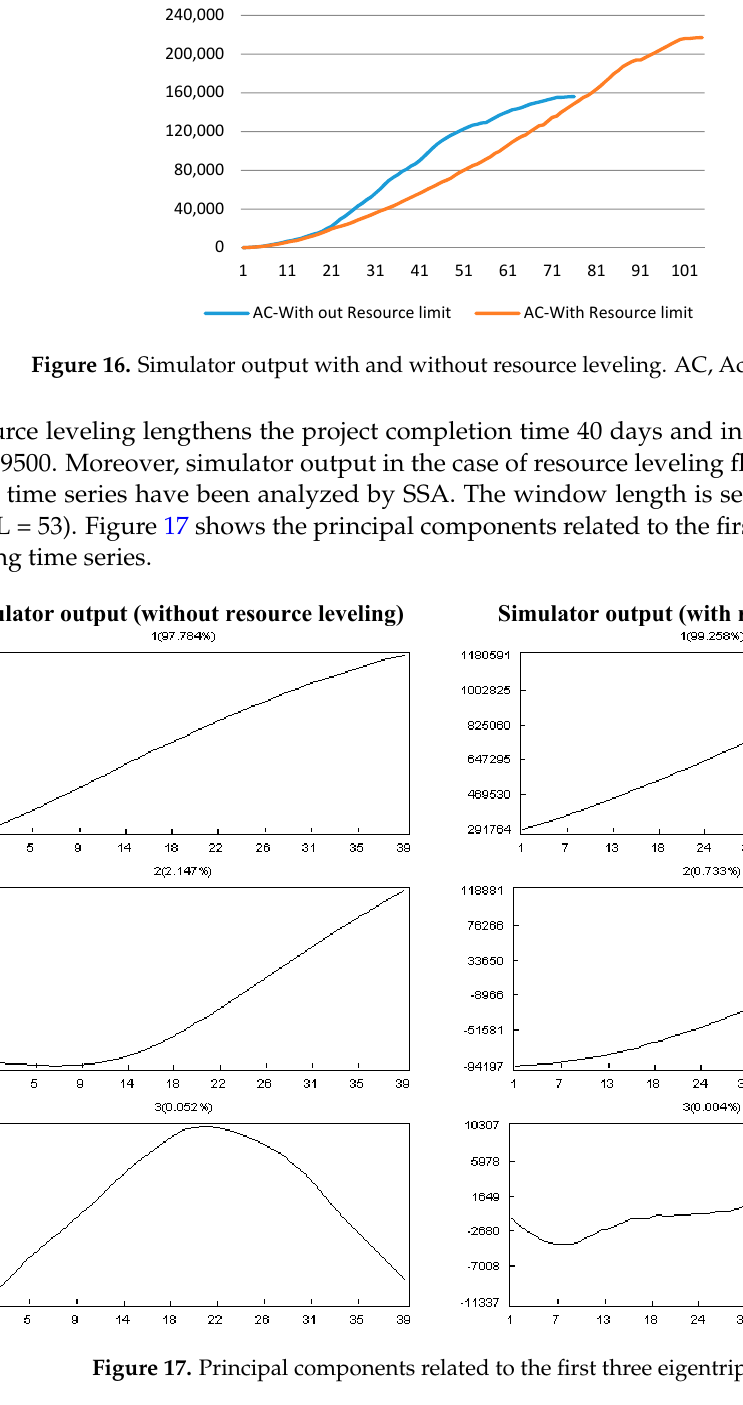
Figure 16. Simulator output with and without resource leveling. AC, Actual Cost.